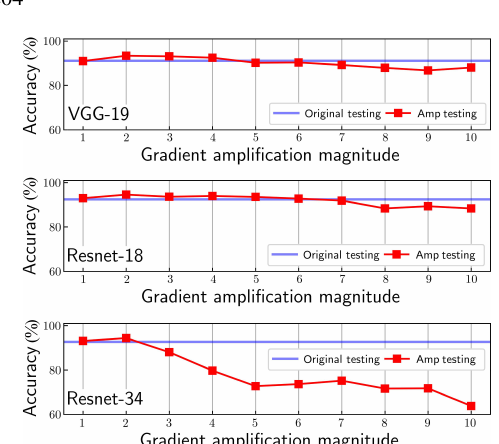
Fig. 6 Performance comparison of amplified models (red) as (cid:0)(cid:0)(cid:0) is varied in small steps from 1 to 3 (horizontal axis) vs. original models (blue).